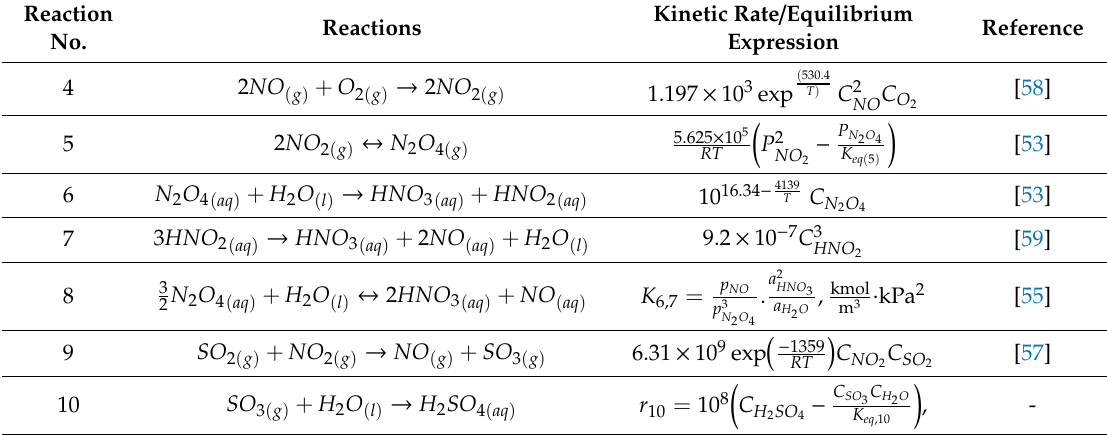
Table 3. Reaction kinetics of NO x and SO x